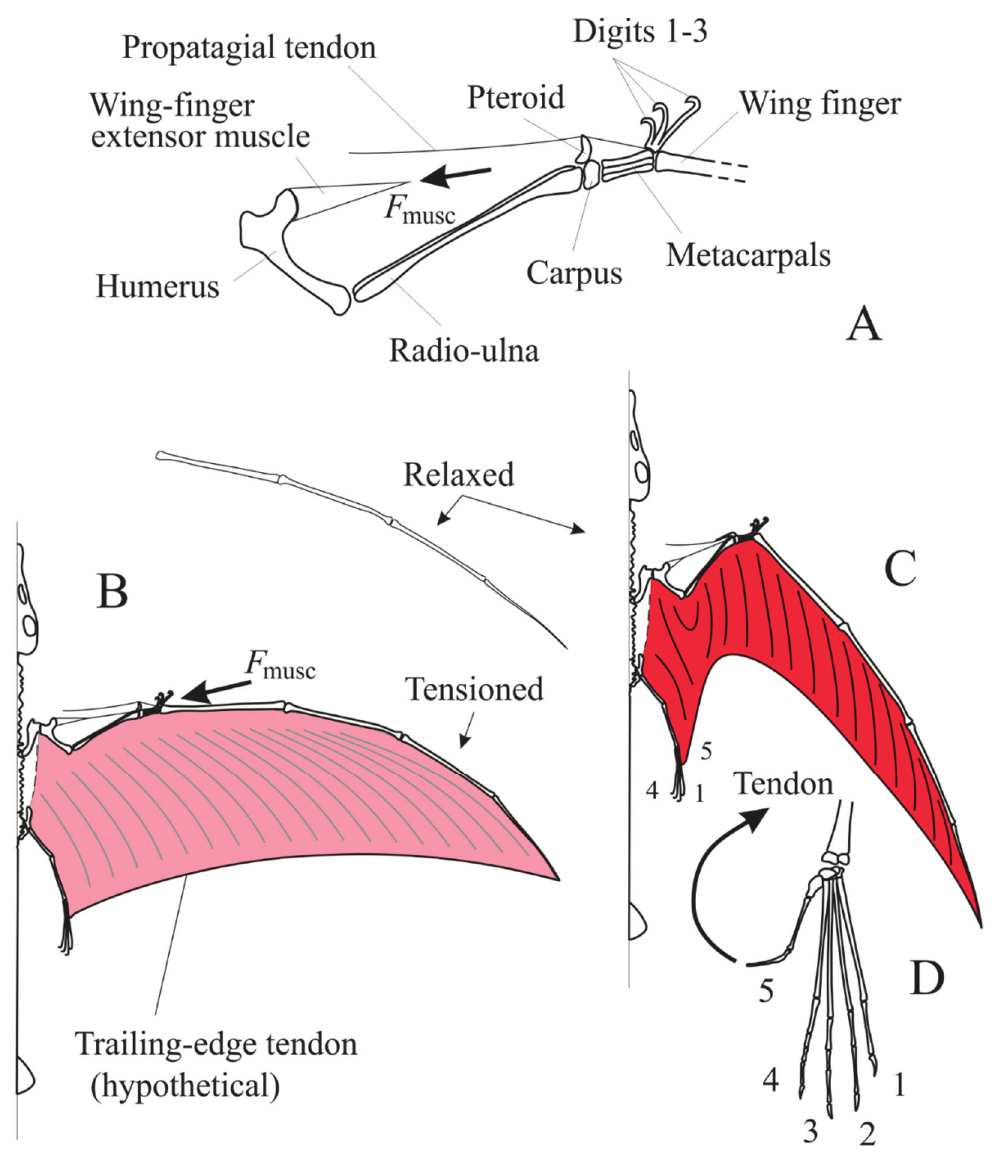
Figure 9. Reconstruction of a blackbird-sized pterosaur. ( A ) Wing skeleton without membrane; ( B ) The wing is pulled open by the wrist muscle ( F musc ), and elastic fibres in the membrane maintain tension as it is stretched; ( C ) The surface wrinkles (“stiffening fibres”) are surface features that only appear when the membrane contracts, especially when it is dead; ( D ) The elongated 5th toe stretches the trailing-edge